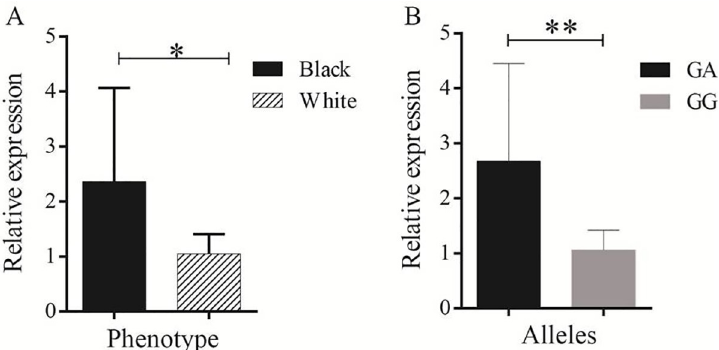
Fig 5. Gene and allele expression level for white and black coat colours phenotype of Chinese Tan sheep. (A) Comparison of gene expression ( MC1R) in black-head and white colour sheep. (B) Expression level comparison between the GG genotype (white coat colour sheep) and GA genotype (black-head coat colour sheep) in the MC1R gene for the rs409651063 variant. The sign � is denoted for P < 0.05 and �� is for P <